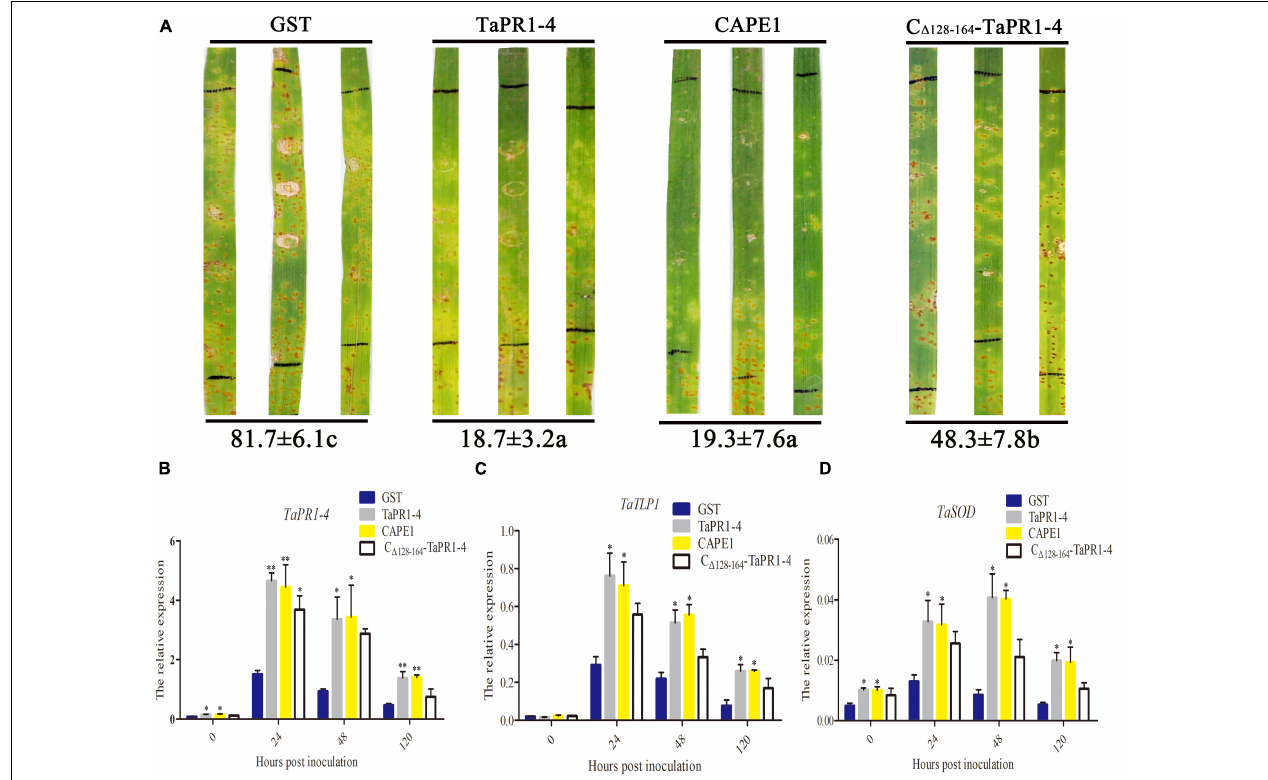
FIGURE 4 | Antifungal activity of CAPE1 in vivo . (A) GST, TaPR1-4, CAPE1, and C (cid:49) 128 − 164 -TaPR1-4 (0.1 mg/ml) were infiltrated into the first leaves of Chinese Spring. Black lines indicate the infiltration zones. The numbers of urediniospores at 14 dpi were quantified using Image J software. (B–D) Expression fold change of TaPR1-4 , TaTLP1 , and TaSOD measured after GST, TaPR1-4, CAPE1, and C (cid:49) 128 − 164 -TaPR1-4 pure protein into susceptible wheat Chinese Spring and inoculated with Pt . Relative expression was expressed as fold change relative to mock-inoculated plants at 0 hpi. The y-axis indicates the amounts of three genes transcript normalized to the GAPDH gene. The x-axis indicates sampling times. Susceptible wheat Chinese Spring infiltration with GST protein was standardized as 1. Values are means ± SEM of three independent biological replicates. Significant differences were assessed using one-way analysis of variance (ANOVA) and Duncan’s multiple range test (DMRT) (* p <